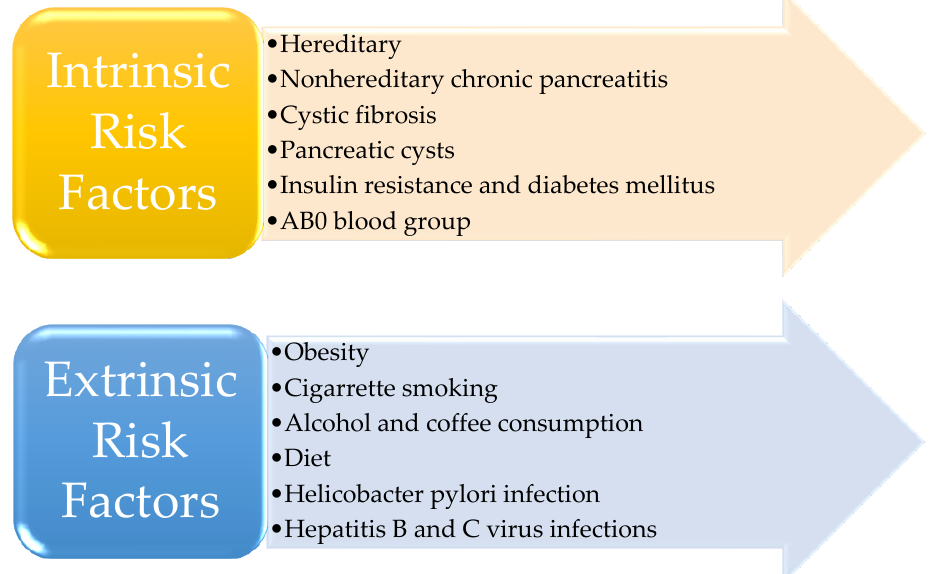
Figure 1. The risk factors for pancreatic cancer.